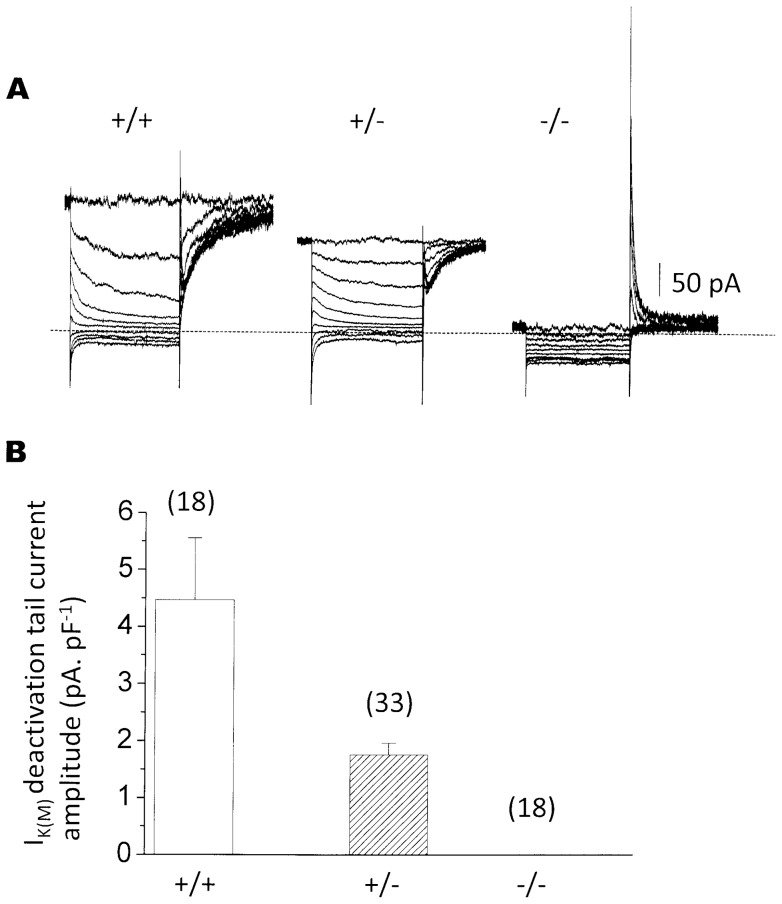
M-currents are absent in embryonic KCNQ2−/− mice and reduced in KCNQ2+/− mice.A, representative currents recorded from +/+, +/− and −/− sympathetic neurons. Currents were recorded using a standard deactivation protocol to isolate IK(M) from other voltage-activated currents. The cell was depolarized to −20 mV to pre-activate IK(M), then hyperpolarized for 1 s to deactivate the current. B, mean current density of the deactivation tail currents on stepping from −20 mV to −50 mV recorded from +/+, +/− and −/− neurons (with numbers of neurons in brackets). Note the different scales in A and B (A: pA total current; B: pA.pF−1).